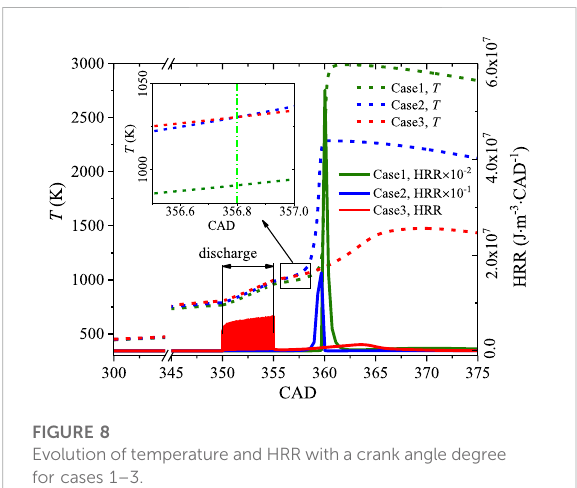
FIGURE 6 Cylinder pressure and temperature pro fi les under motor run, NRPD, and equilibrium discharge.